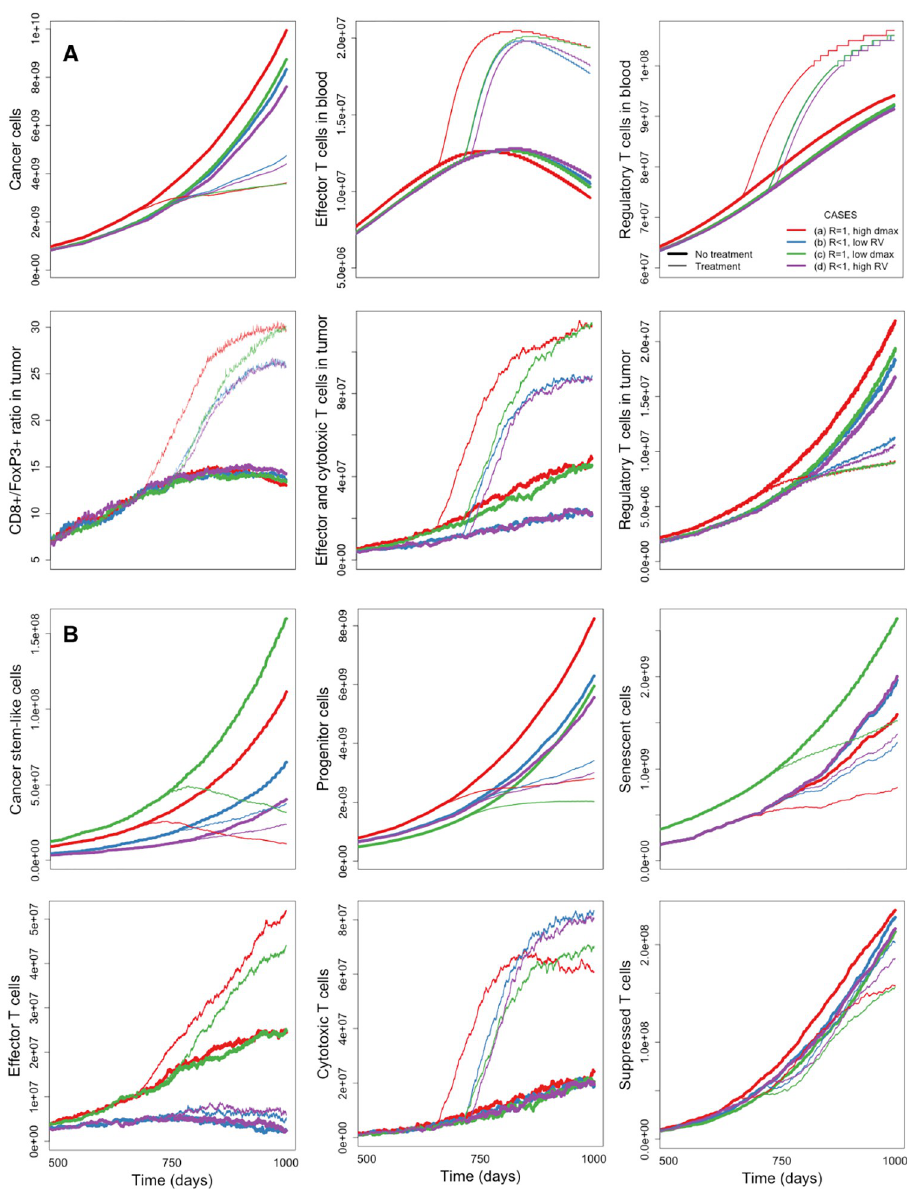
Fig 6. Temporal evolution of cells in the tumor microenvironment under different tumor growth conditions without and with immunotherapy. Panel A: variation in time of number of cancer cells, T cells in central and tumor compartments, and CD8+/FoxP3+ ratio. Panel B: variation in time of cancer cell and CD8+ T cell subtypes. Thick and thin red lines represent cases (a) and (a � ) without and with immunotherapy, respectively ( R ~ 1, 10% of the grid occupied by voxels with cell recruitment sources, and d = 9); thick and thin blue lines represent cases (b) and (b � ) max without and with immunotherapy, respectively ( R < 1, 10% of the grid occupied by voxels with cell recruitment sources, and d = 9); thick and thin green lines represent cases (c) and (c � ) without and with immunotherapy, max respectively ( R ~ 1, 10% grid occupied by voxels with cell recruitment sources, and d max = 4); thick and thin purple lines represent cases (d) and (d � ) without and with immunotherapy, respectively ( R < 1, 30% of the grid occupied by voxels with cell recruitment sources, and d max =